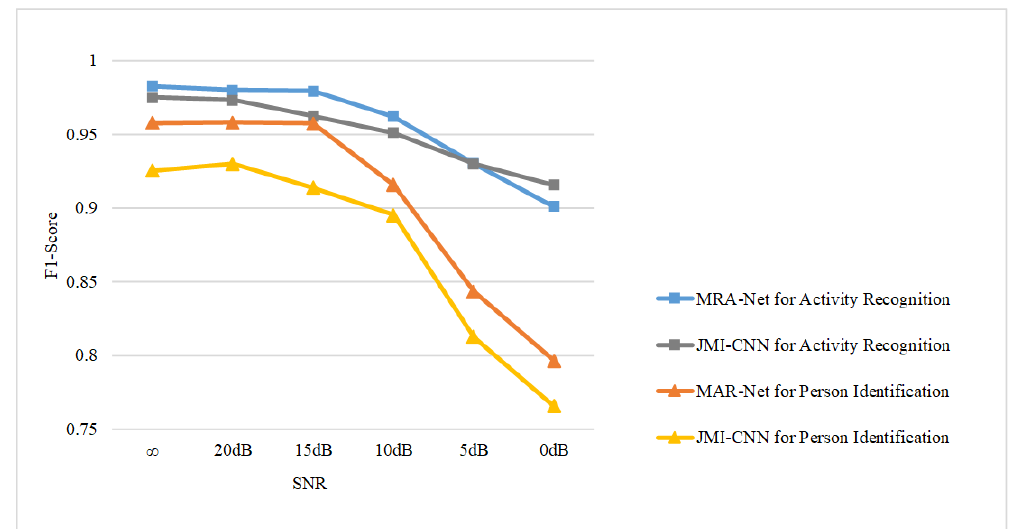
Figure 11. Performance comparison of MRA-Net and JMI-CNN for MTL under different